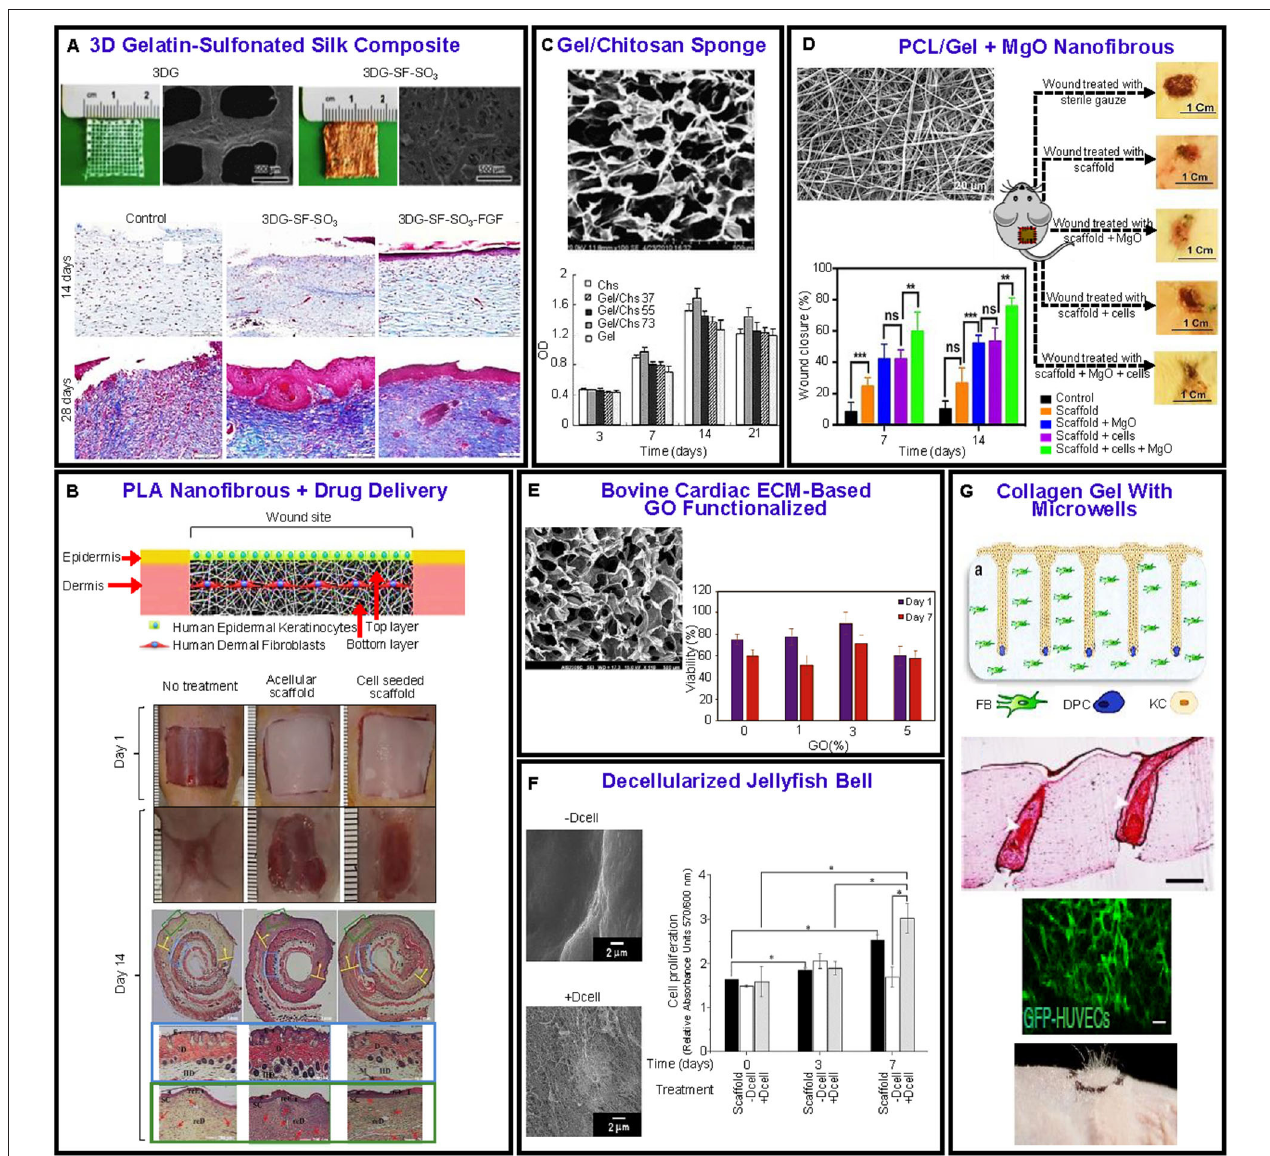
FIGURE 7 | Examples of recent advances in biomaterial scaffolds for skin wound healing. (A) Gelatin sulfonated silk scaffolds with FGF-2 growth factor. Masson trichrome staining shows the histology of a repaired wound. The treated samples reveal an increase in collagen content with time relative to the control sample (Xiong et al., 2017). (B) Ibuprofen-loaded PLA layered scaffold seeded with fibroblasts and keratinocytes. Wound closure at 1 and 14 days and histological staining of skin samples at 14 days from control wound sites without scaffolds, with acellular scaffold, and cell-seeded scaffold (Mohiti-Asli et al., 2017). (C) Gelatin/chitosan freeze-dried scaffold showing enhanced cell viability (Han et al., 2014). (D) Hybrid PCL/gel fibrous scaffold loaded with MgO particles showing significantly more wound healing compared to controls (Ababzadeh et al., 2020). (E) Porous structure of bovine cardiac ECM-GO functionalized scaffold. Cell viability vs. GO content (Jafarkhani et al., 2020). (F) Decellularized ( + Dcell) and non-decellularized (–Dcell) jellyfish bell scaffolds. Fibroblast cell proliferation after 0, 3, and 7 days shows a significant difference between + Dcell and –Dcell at 7 days of culture (Fernández-Cervantes et al., 2020). (G) Schematic of scaffold and cells seeded, histological staining showing differentiated keratinocyte morphology and graft vascularization, and high follicle density engraftment (Abaci et al., 2018).